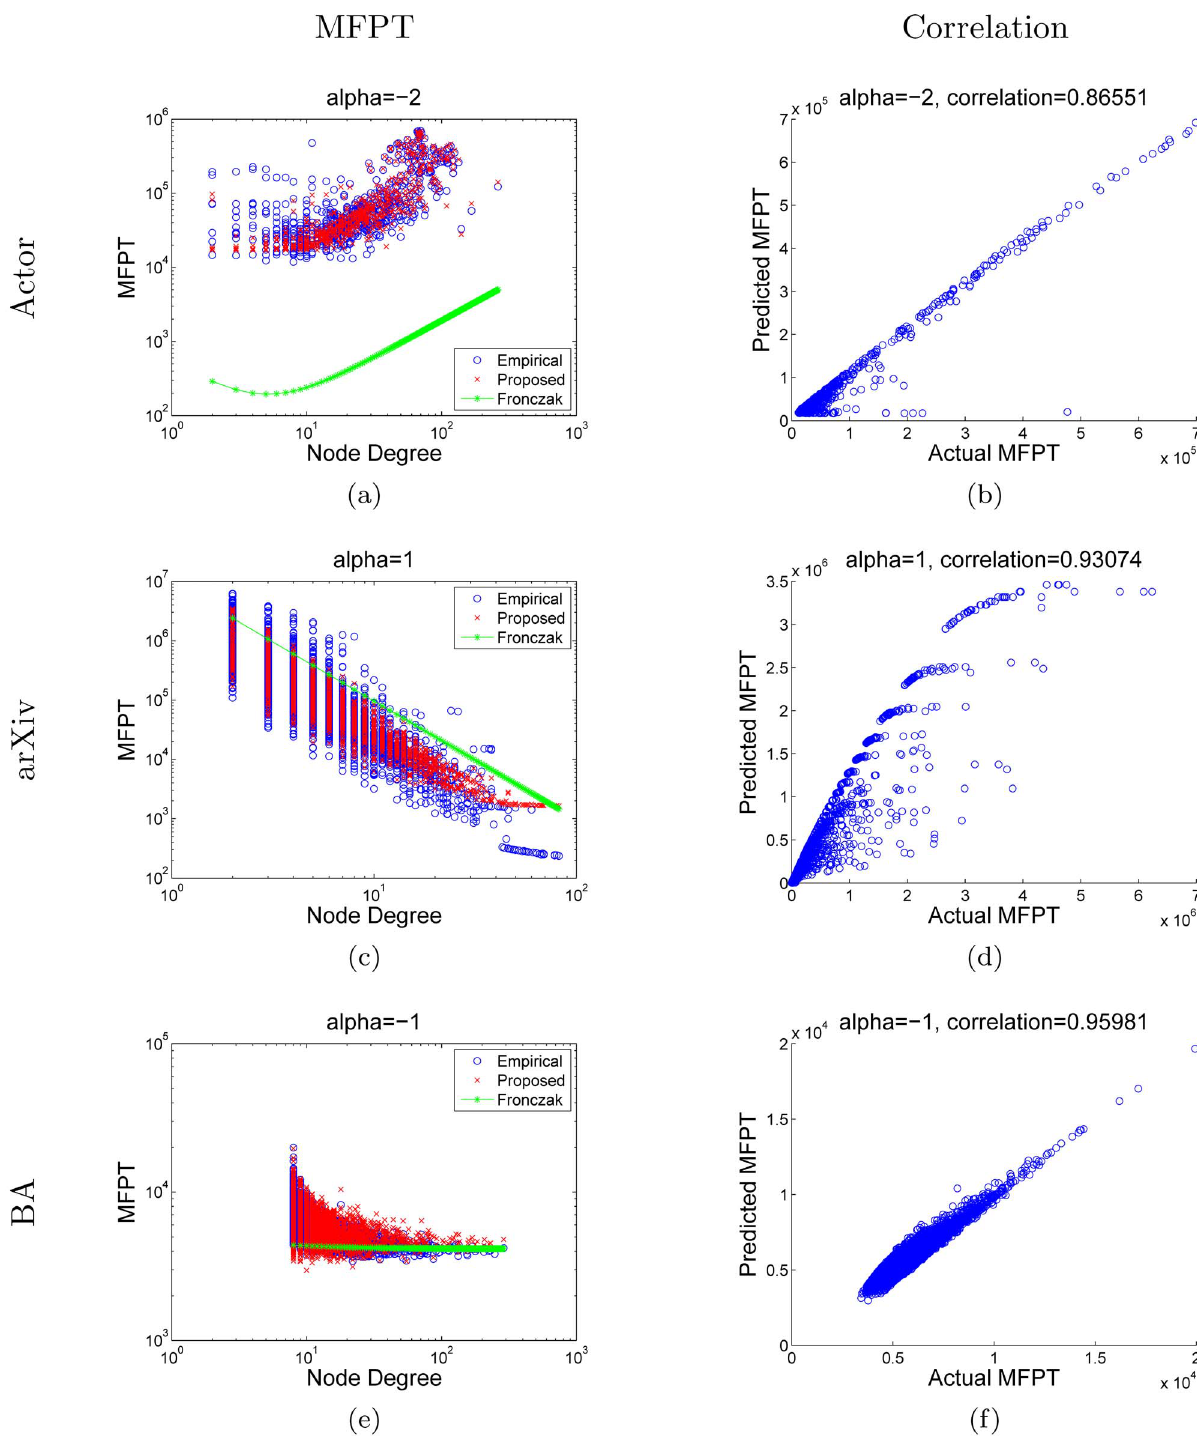
Figure 3. Comparison of MFPTs obtained from simulation against that obtained from using the bound shown in Ineq. (16). The column on the left compares the empirical MFPT to the results obtained by (i) using the bound in Ineq. (16); (ii) using the result presented in [8]. The column on the right shows the scatter plot and correlation between the empirical results and our proposed theoretical results. The rows correspond to the Actor, arXiv, and BA network respectively. While the result presented by Fronczak et al. [8] gives the general trend of MFPTs with respect to node degree, we find that the MFPTs for a given node degree are distributed across a wide range and cannot be fitted with a function of the node degree alone. The scatter plots show a strong correspondence between the empirical results and our proposed theoretical results. This is further supported by the high Pearson correlation coefficients which are shown on top of the scatter plots.